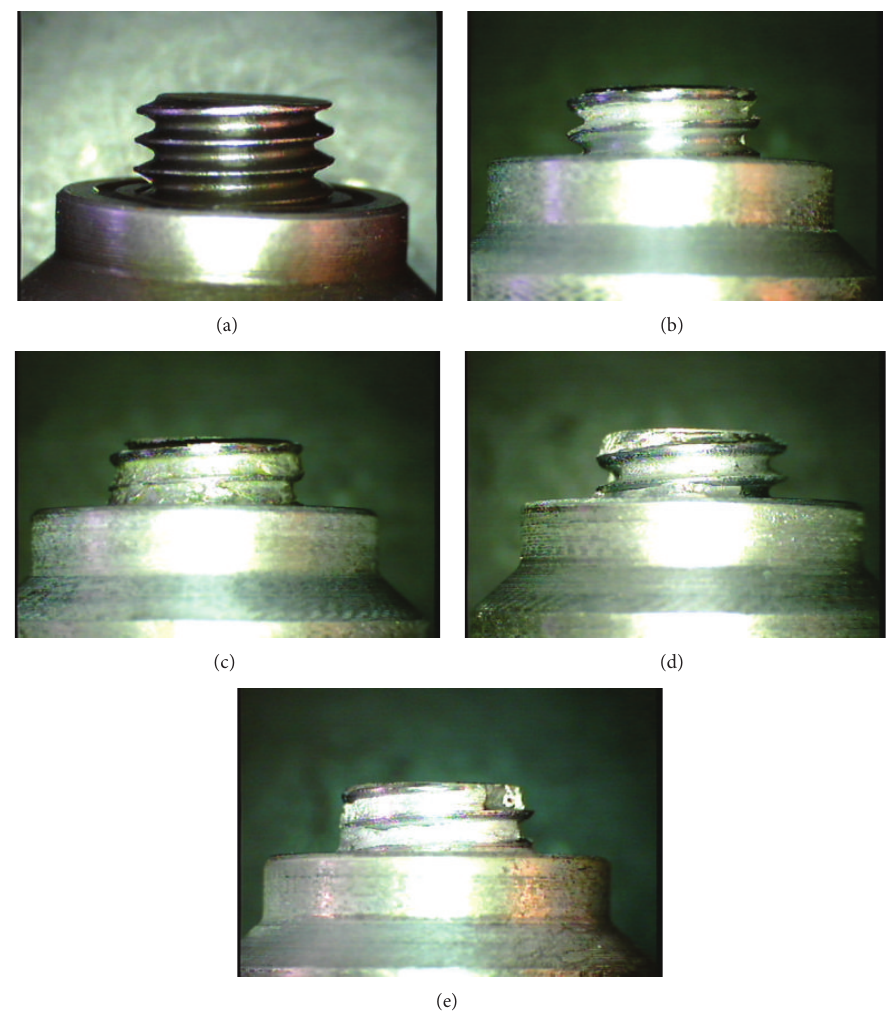
Figure 36: Wear of the tool pin after processing the sheets: (a) new tool, (b) 7550 mm, (c) 11710mm, (d) 19070 mm, and (e) 25150 mm.